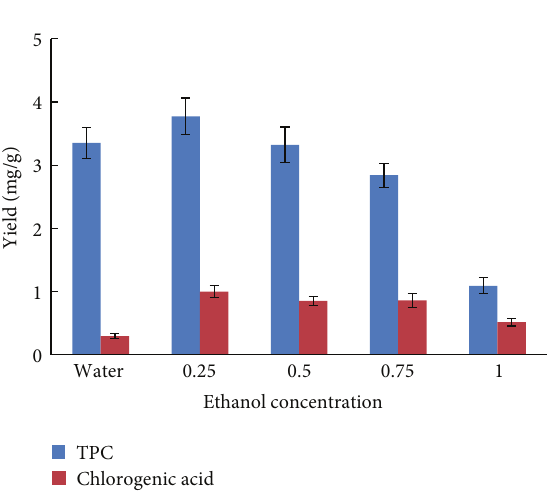
Figure 1: The HPLC chromatogram of chlorogenic acid (1) in the root of I. helenium (Column, Hypersil C 18 column ( 200 mm × 4.6 mm); mobile phase, acetonitrile: 0.1% phosphoric acid (10: 90); flowrate,1mL/min;columntemperature,30 ∘ C;wavelength,327 nm; injection volume, 20 𝜇 L).